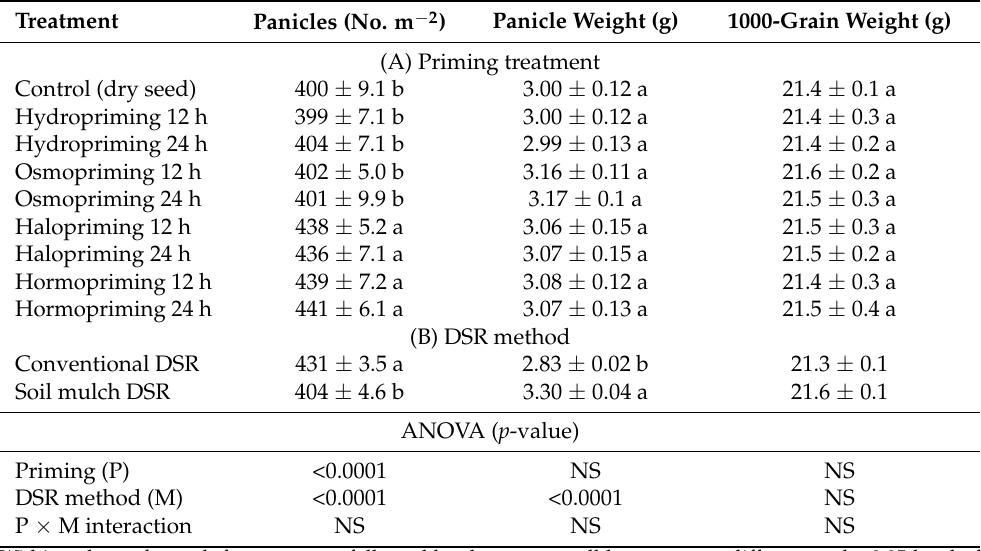
Table 9. Yield attributes (panicle no., panicle weight, and 1000-grain weight) of rice as affected by different seed priming and DSR establishment methods during 2019 at Ludhiana, India.